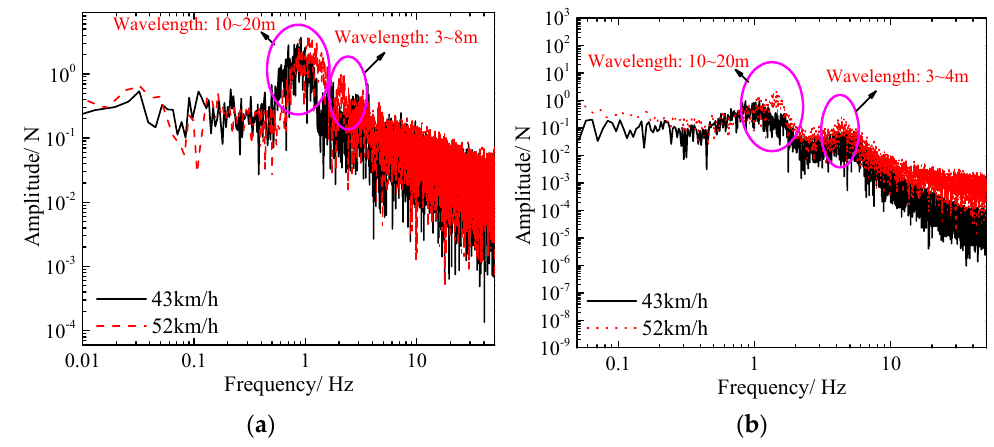
Figure 10. PC contact force under two speeds: ( a ) normal force; ( b ) friction force.